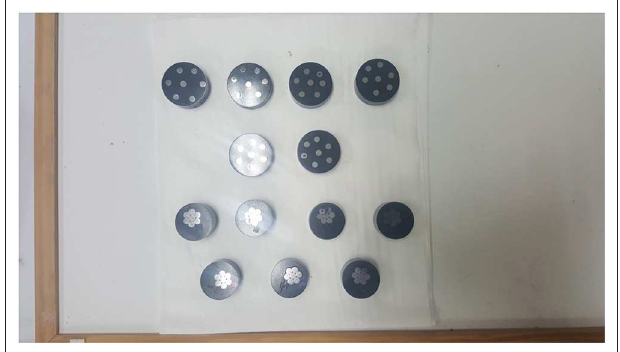
FIGURE 1 | Embedded and polished sample after corrosion